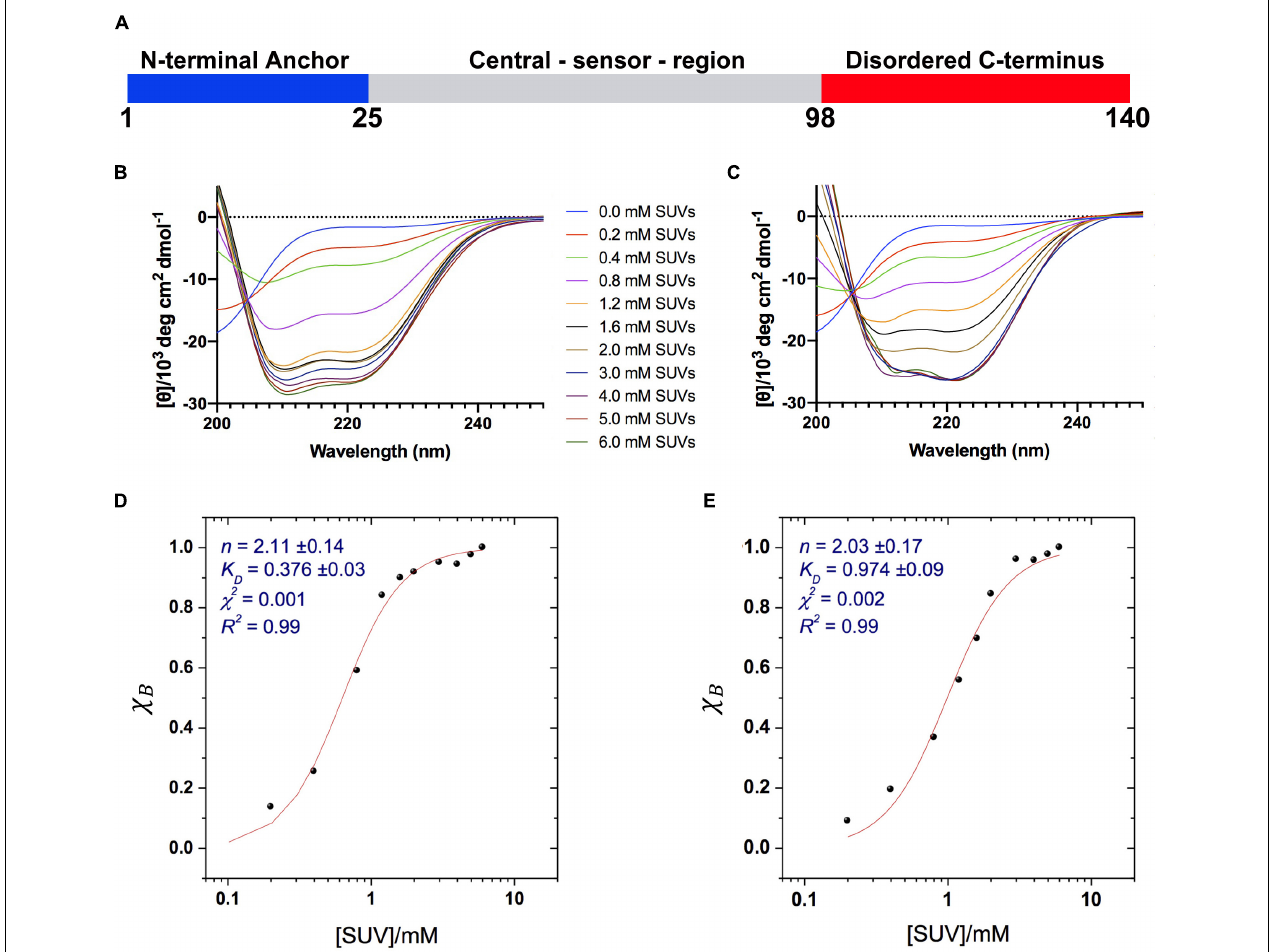
FIGURE 1 | Binding of α S to acidic SUVs. (A) Three regions of α S were found to have specific structural and dynamical properties at the surface of SUV-0% (Fusco et al., 2014). These include the N-terminal anchor (residues 1–25, blue), whose ssNMR resonances spanning the region 6–25 were previously assigned (Fusco et al., 2014), the central sensor region (residues 26–97, gray), and the C-terminal domain (residues 98–140, red) remaining essentially unbound and disordered at the membrane surface. (B–E) CD measurements of α S binding to acidic SUV-0% (B,D) and SUV-31% (C,E) . In all measurements the concentration of α S was kept constant at 10 µ M whereas the concentrations of SUV-0% and SUV-31% were calculated by considering exclusively the DOPE:DOPS:DOPC component in both types of vesicles. (B,C) CD titration in 20 mM buffer, pH 6.0 measured at 10 ◦ C for SUV-0% (B) and SUV-31% (C) . (D,E) Fitting of the CD titrations following the signal at 222 nm, [ θ ] 222 nm for SUV-0% (D) and SUV-31% (E) . The Hill equation was used to account for both binding constant K D and the cooperativity, which is fitted with the Hill coefficient n